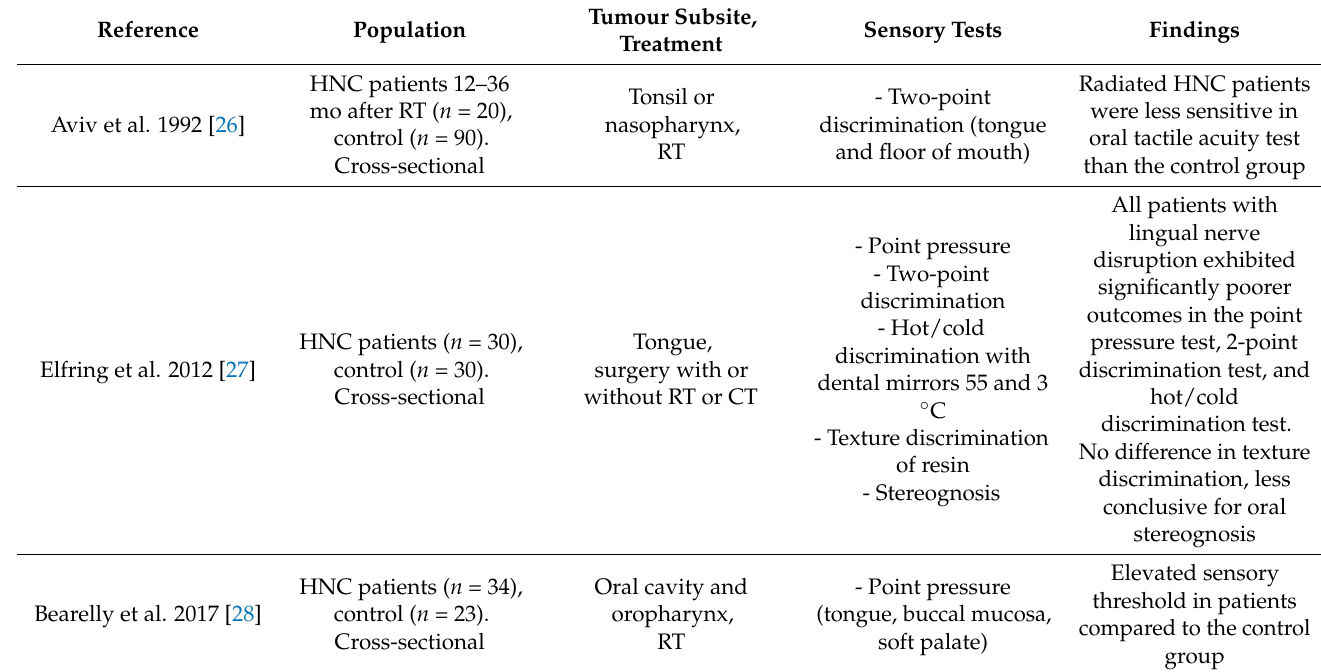
Table 1. Summary of psychophysical studies investigating oral somatosensory perception in head and neck cancer